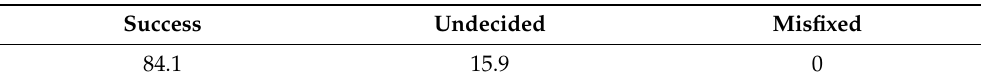
Table 10. Fixing rate of the single-epoch ambiguity resolution of a subset of narrow lanes L1 and L5 (%). Success Undecided Misfixed 84.1 15.9